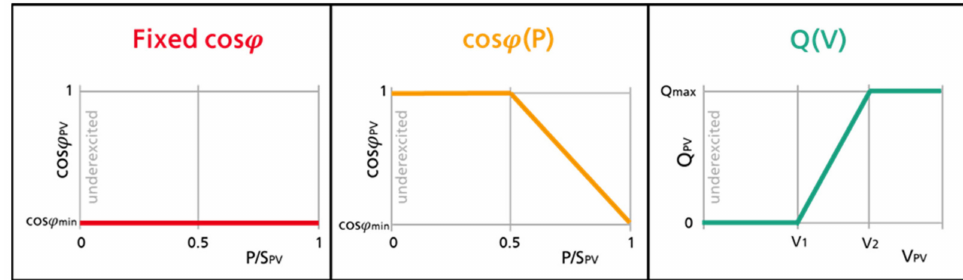
Figure 12. Different local voltage control strategies at LV levels. Table 2. Parameter for the local control strategies at the LV level (only underexcited Q provision).